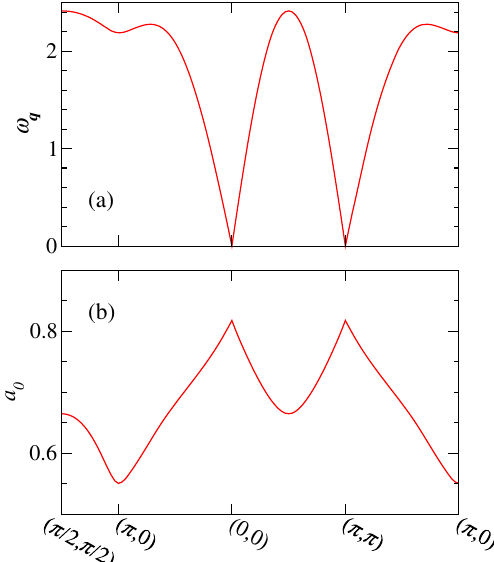
FIG. 19. Dispersion relation (a) and wave-vector dependence of the relative weight of the magnon pole (b) calculated with the effective Hamiltonian with the parameters c m ¼ 3 . 1 , c s ¼ 3 . 1 , Δ ¼ 1 . 94 , g ¼ 1 . 86 , and the spinon-spinon potential V ð r Þ ¼ − 6 . 2 e − r= 2 .